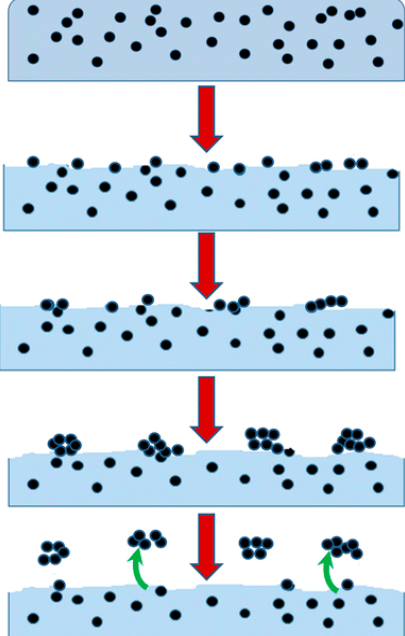
Figure 11. Model for release of nano-SiO 2 fillers from a hybrid composite: matrix degradation, formations of particle clusters, and release of particle clusters under increasing UV exposure (from up to bottom). Reprinted with permission from [42]. Copyright 2016 Springer.